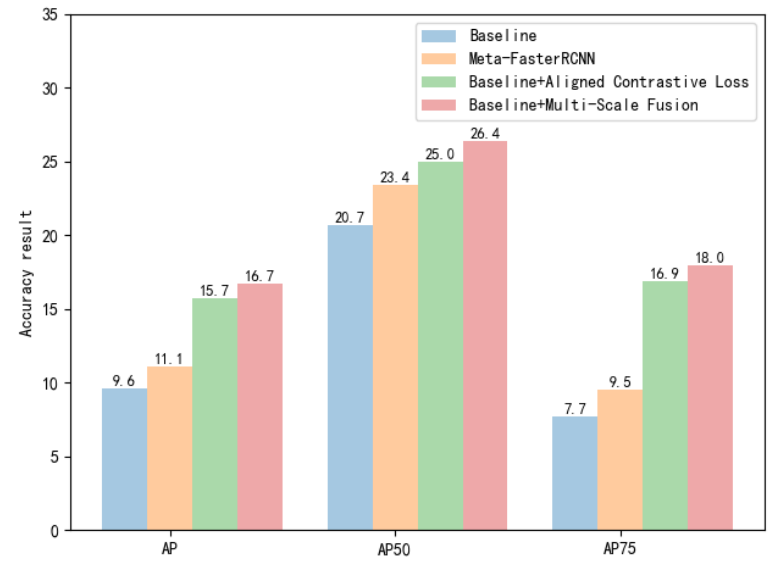
Figure 10. The detection result of Aligned Contrastive Loss and Multi-Scale Fusion on MS COCO